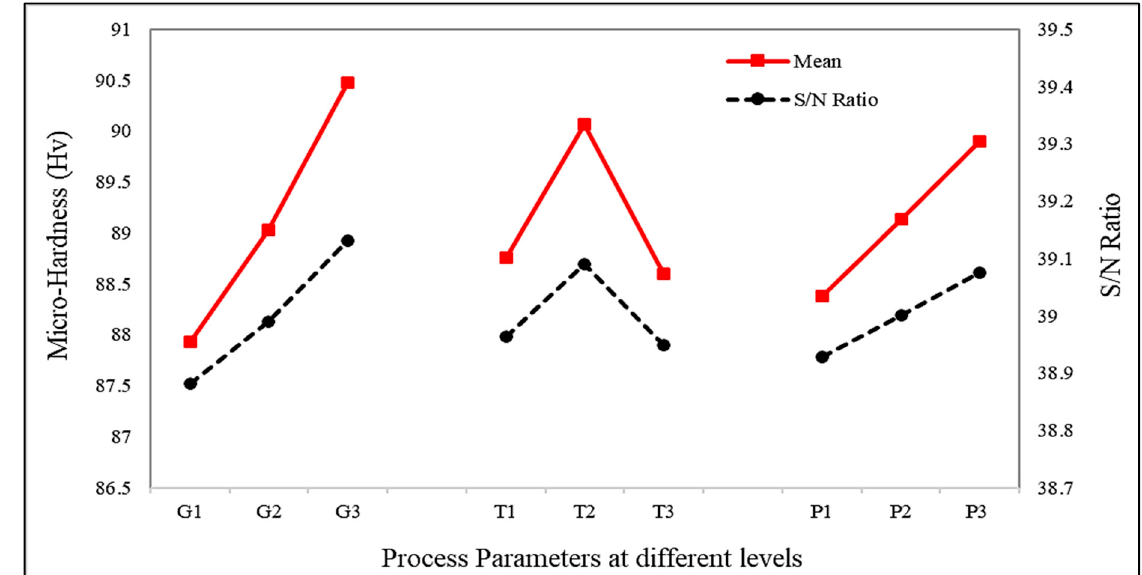
Figure 9. Effects of process parameters on micro-hardness.